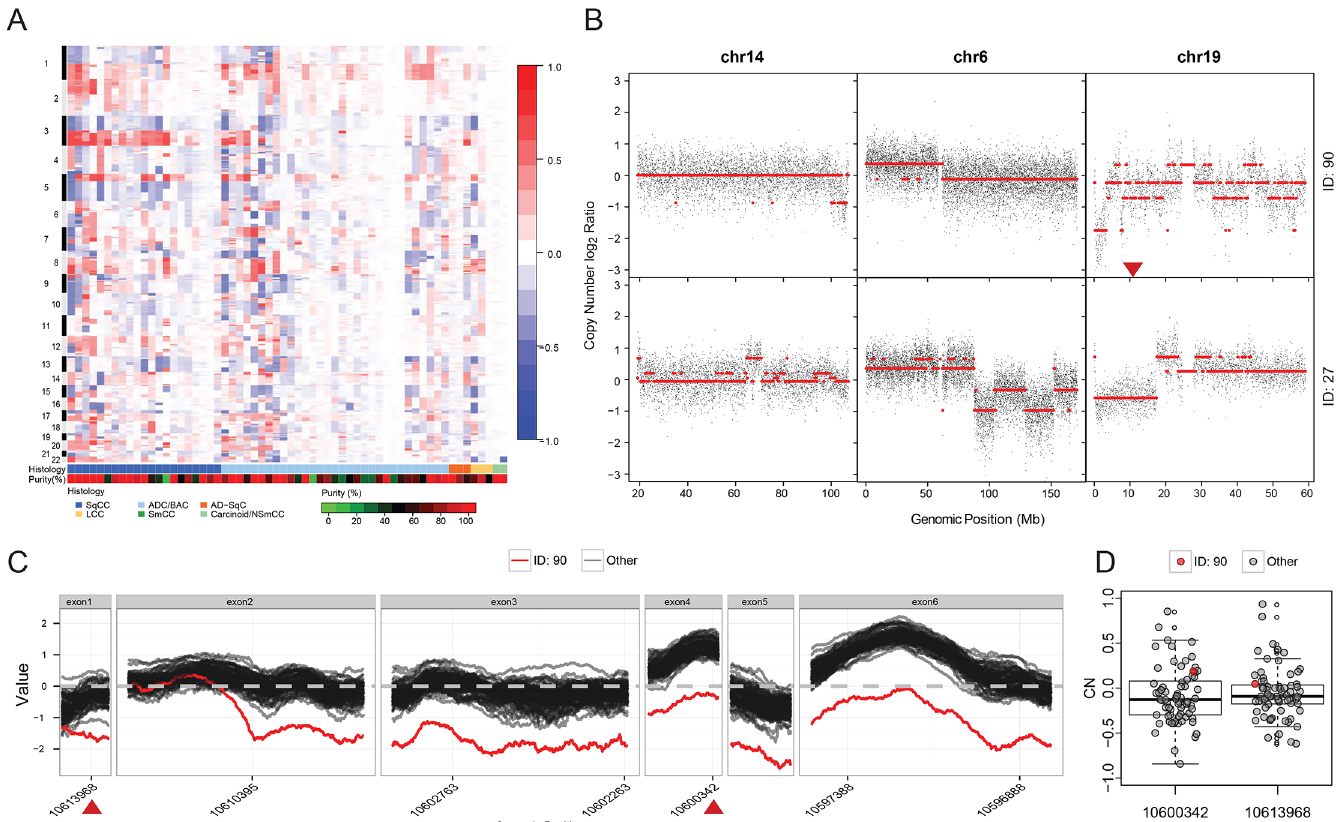
Fig 5. DNA Copy Number Analysis Using Affymetrix Human SNP Array 6.0 Microarray (Panel A) and UNCseq (Panel B, C) or Both (Panel D) of Lung Cancer Samples. (A) Copy number gains (red) and losses (blue) are plotted along the normal genome per each chromosome for each of the 60 completed tumor samples in relation to tumor histology and tumor purity. (SqCC: Squamous Cell Carcinoma; SmCC: Small Cell Carcinoma; ADC/BAC: Adenocarcinoma or Bronchio-alveolar Carcinoma; LCC: Large Cell Carcinoma; AD-SqC: Adenosquamous Carcinoma or Combined/Mixed; Carcinoid/ NSmCC: Carcinoid-Atypical, Carcinoid-Typical, or Non-small cell carcinoma) (B) Examples of chromosome-level CNV in various chromosomes (6, 14, and 19) using UNCseq in two tumor samples (27 and 90). Black dots represent the per nucleotide relative copy number ratios (CNRs) in log 2 . Segmentation- derived regions of equal copy number are indicated in red lines. A red triangle at 10.6 Kbp position of chromosome 19 in the sample (ID: 90) indicates the zoomed regions in panel C. (C) Example of small (gene-level) structural variations across exons (from 5 ’ to 3 ’ ) of the KEAP1 gene (RefGene ID: NM_203500 ) for all (black) but one (red) tumor samples. Markers from the Genome-Wide Human SNP Array 6.0 corresponding to the chromosome area where KEAP1 gene is located are highlighted in red triangles. (D) Boxplot analysis illustrating the SNP array signals at these two markers in C. Signals of tumor sample 90 are in